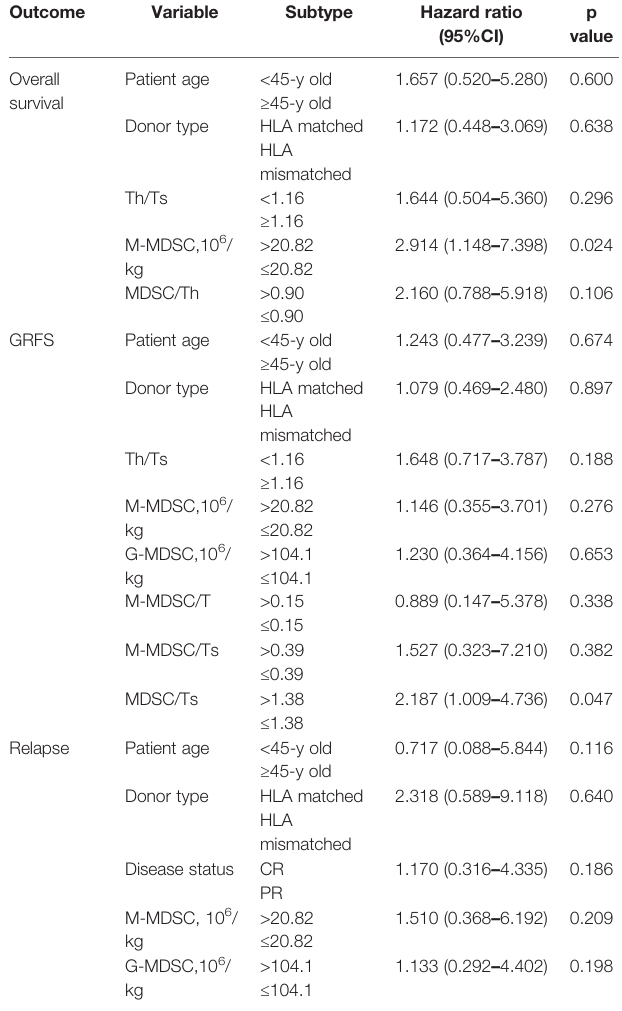
TABLE 6 | Multivariate analysis for OS, GRFS and Relapse.